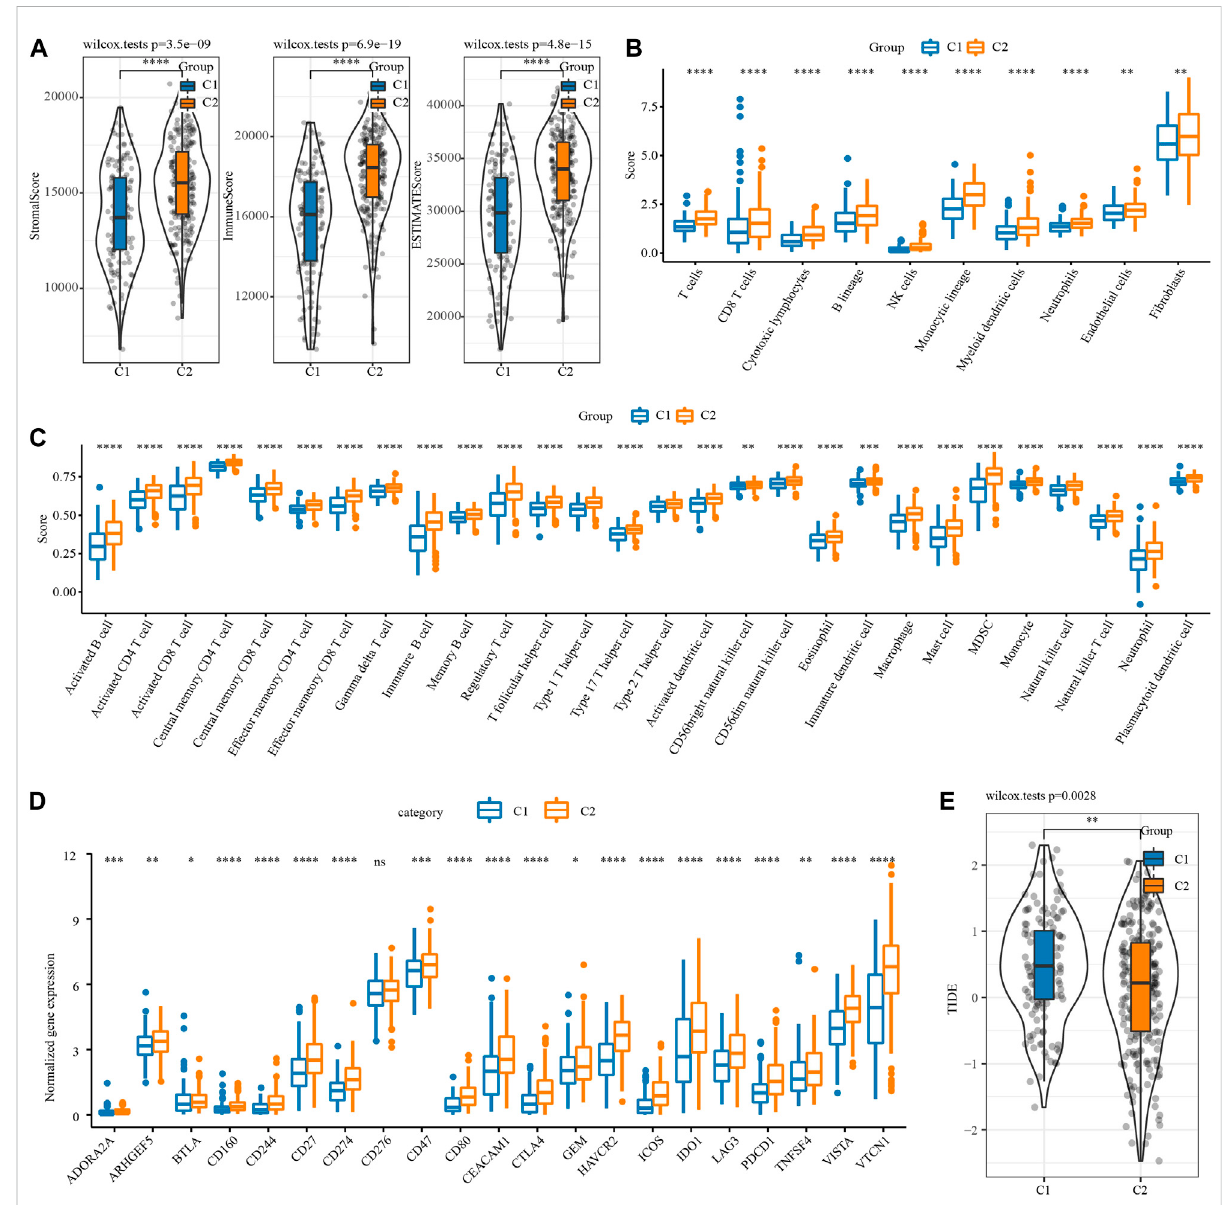
FIGURE 2 Immune microenvironment analysis and immunotherapy response prediction of necroptosis subtypes of OV. (A) The stromal score and immune score and tumor purity of two necroptosis subtypes in TCGA. (B) The in fi ltration scores of 10 immune cells calculated by MCP-Counter in the two necroptosis subtypes of OV. (C) The enrichment scores of 28 tumor-associated immune cells evaluated by ssGSEA in the two necroptosis subtypes of OV. (D) The box chart shows the association between the two necroptosis subtypes of OV and the expression of immune checkpoints. (E) TIDE score of two necroptosis subtypes of OV in TCGA. * p < 0.05, ** p < 0.01, *** p < 0.001, **** p <